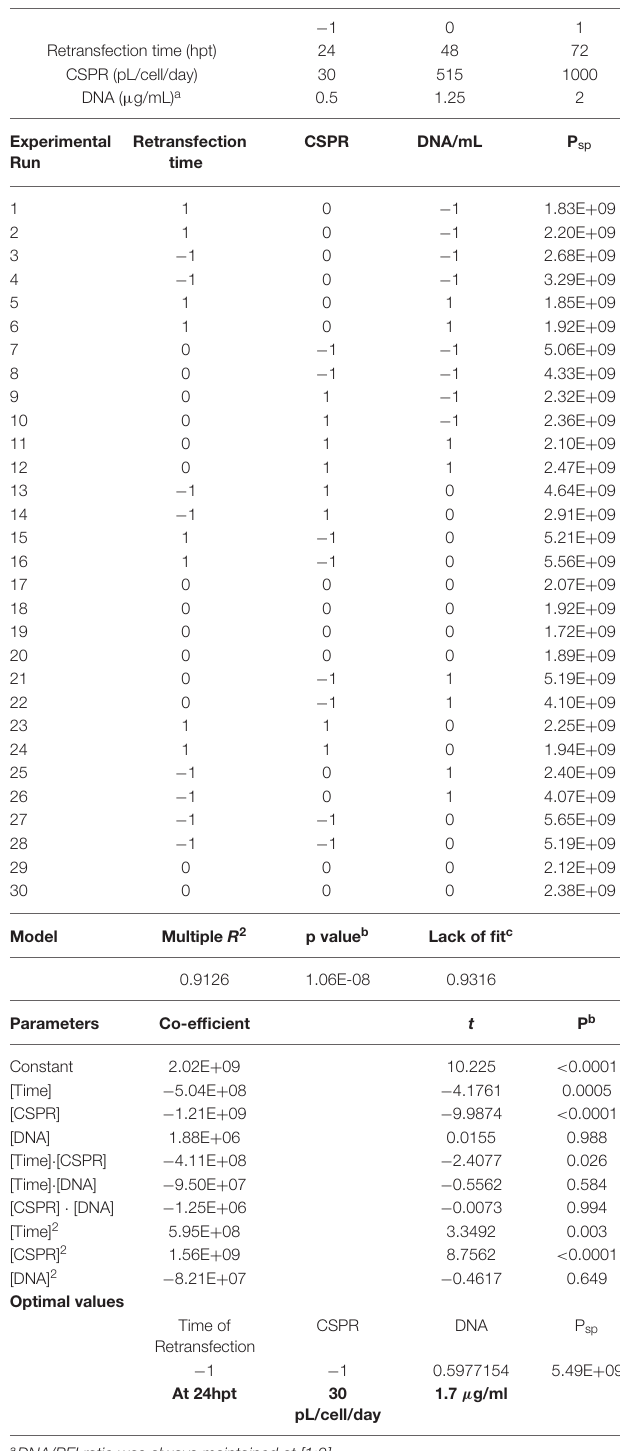
TABLE 1 | Box-Behnken design, results and ANOVA analyses for optimization of the extended gene expression (EGE) protocol for VLP production. −